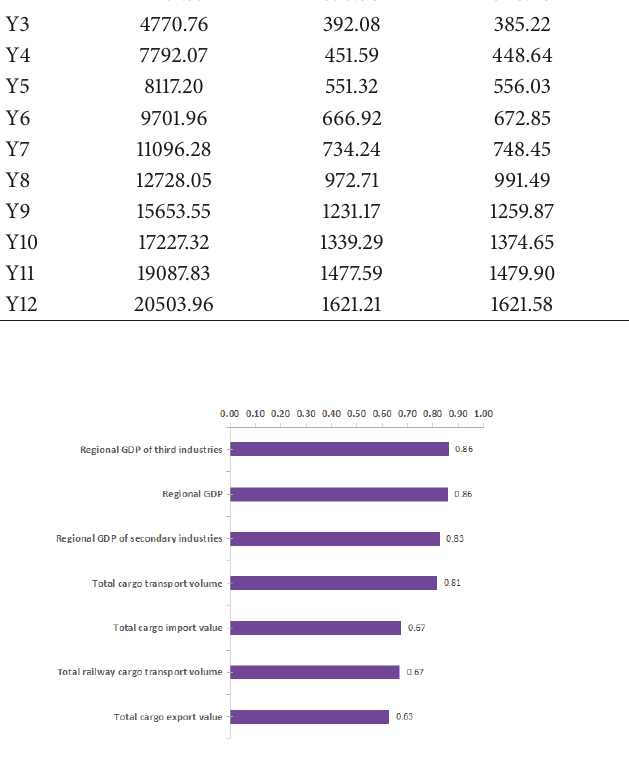
Figure 7: Correlations between seaport’s indicators and its dry ports’